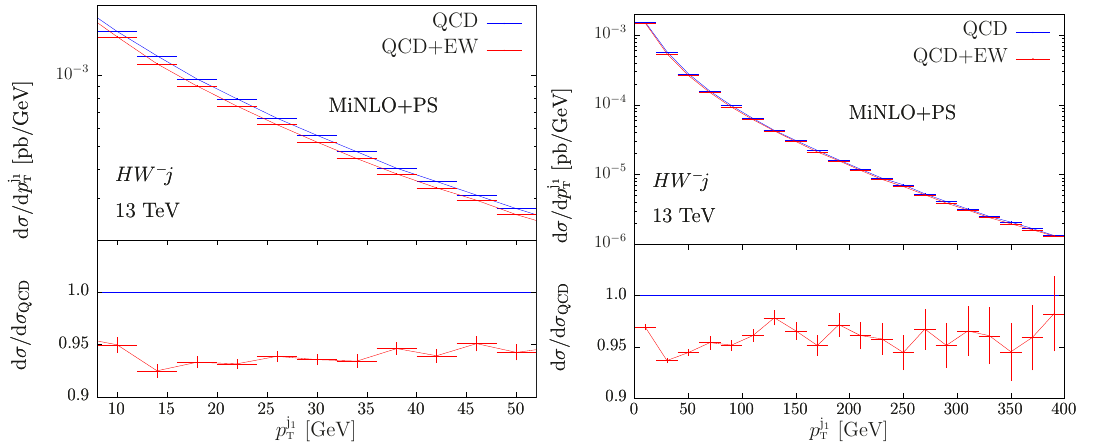
Figure 22. MiNLO +PS predictions for the transverse momentum of the leading jet in two transverse-momentum ranges in HW (cid:0) j production. Same curves and labels as in (cid:12)gure 20. regime ((cid:12)gure 23) features the typical Sudakov EW behavior, with negative EW correc- tions that exceed 20% in the tail. In the leading-jet p distribution ((cid:12)gure 24) we observe T (cid:0) relatively small and rather constant EW corrections. Both distributions behave similarly as the corresponding distributions for HW (cid:0) j